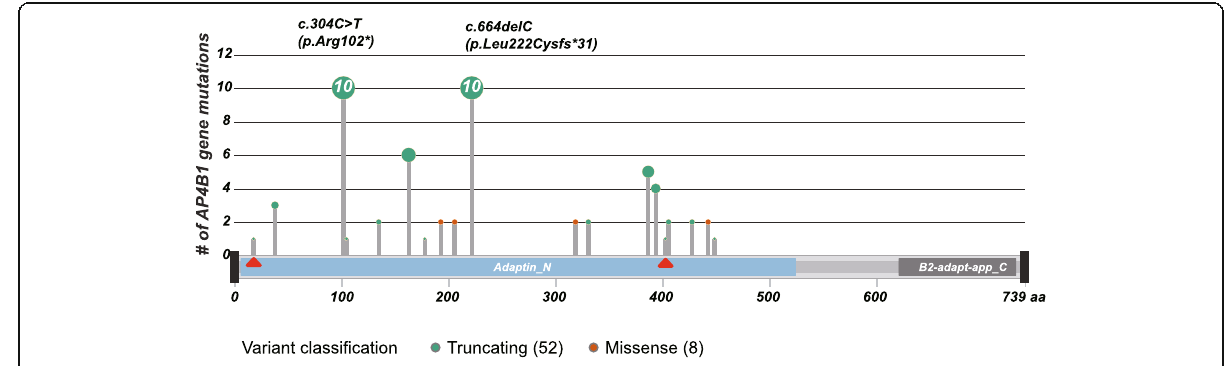
Fig. 4 Lollipop graph shows mutations in AP4B1 gene reported in literatures. Red triangles indicate the two variants identified in our